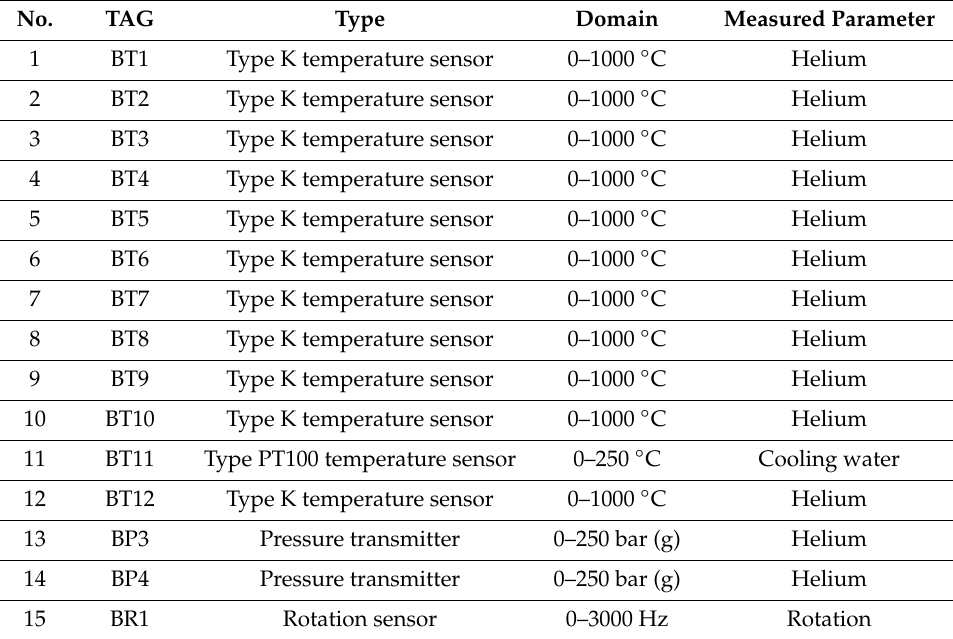
Table 2. Parameters of the experimental set-up.